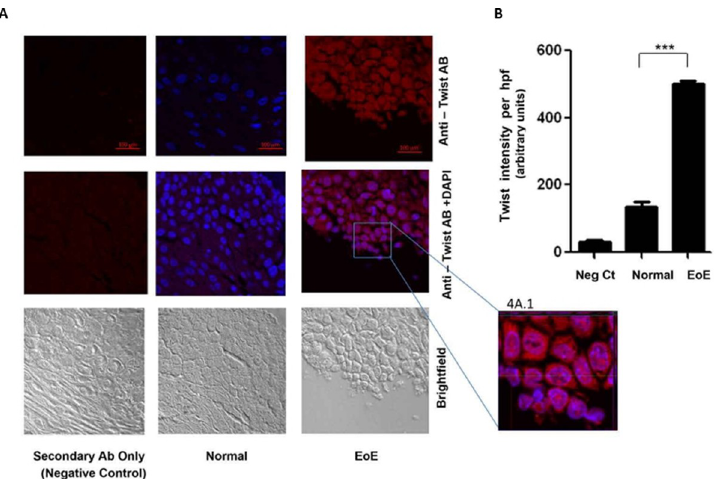
Fig 7. IF analysis of TWIST1 in esophageal tissue from pediatric control (0–5 Eos/HPF) and EoE patients ( > 15 Eos/HPF). A. Representative photomicrograph of immunostaining with anti-TWIST1 antibody; A.1. 60X photomicrograph showing Twist present exclusively in nuclei. B. Densitometric analysis of TWIST1 staining in EoE and control patient esophageal biopsy tissue. Values are representative of the mean of a sample size of 18 control and 18 patients with EoE. ��� P <